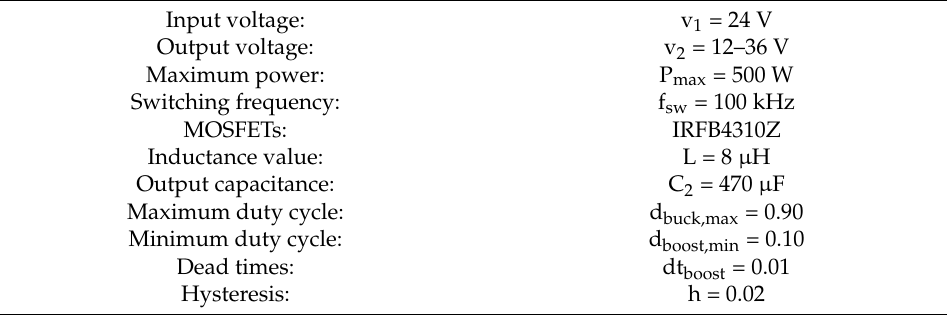
Table 6. Specifications of 4SBB to obtain simulation and experimental